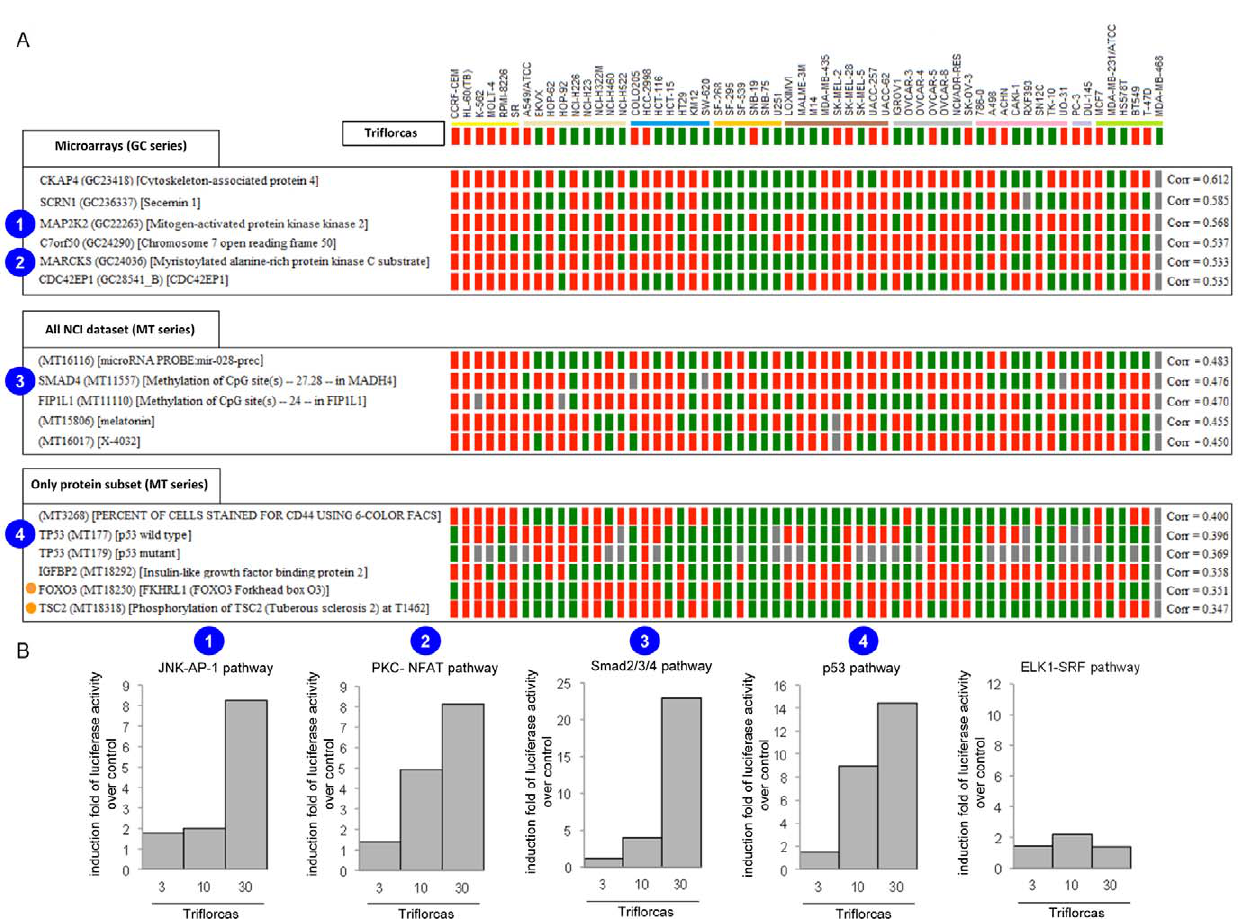
Figure 11. Molecular signature outcomes revealed by bioinformatic analysis of the NCI Anticancer Drug Screen. (A) Results showing a short list of molecular targets belonging to the individual datasets and displaying high positive correlation values (on the right). (B) GTL-16 cells were transfected with plasmids carrying the luciferase reporter gene controlled by the promoter of p53, Smad2/3/4, AP-1 (readout of the MAP2K2- JNK pathway), NFAT (readout of the PKC-MARCKS pathway), and Elk1-SRF (readout of ERK pathway). Luciferase activity was measured in cells after 48 hours of treatment with vehicle or Triflorcas ( m M). Note that Triflorcas enhanced luciferase activity controlled by p53, Smad2/3/4, AP-1, NFAT, but not Elk1-SRF, promoters. Representative results of independent experiments are